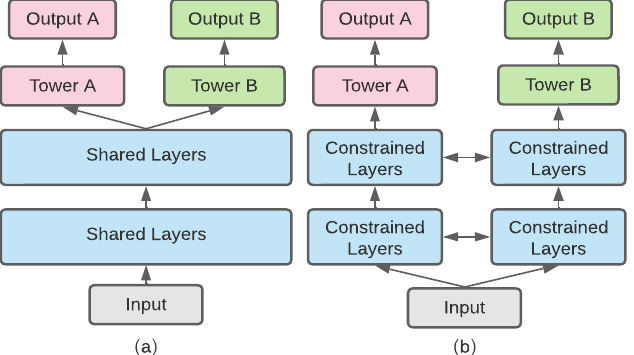
Figure 1. ( a ) Hard parameter sharing model; ( b ) soft parameter sharing